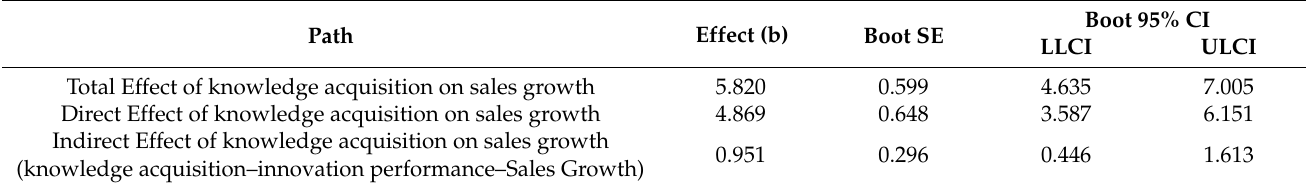
Table 3. Bootstrap significance test for total, direct, and indirect effects of emerging-economy firms’ (E-E firms) knowledge acquisition on sales